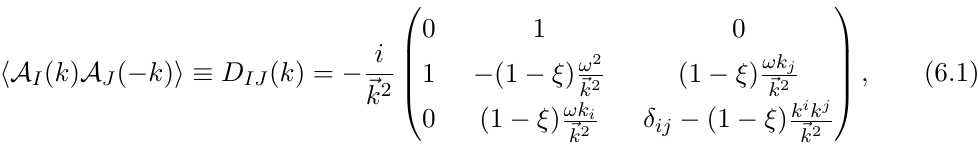
Figure 1 . GED propagator hA I A J i